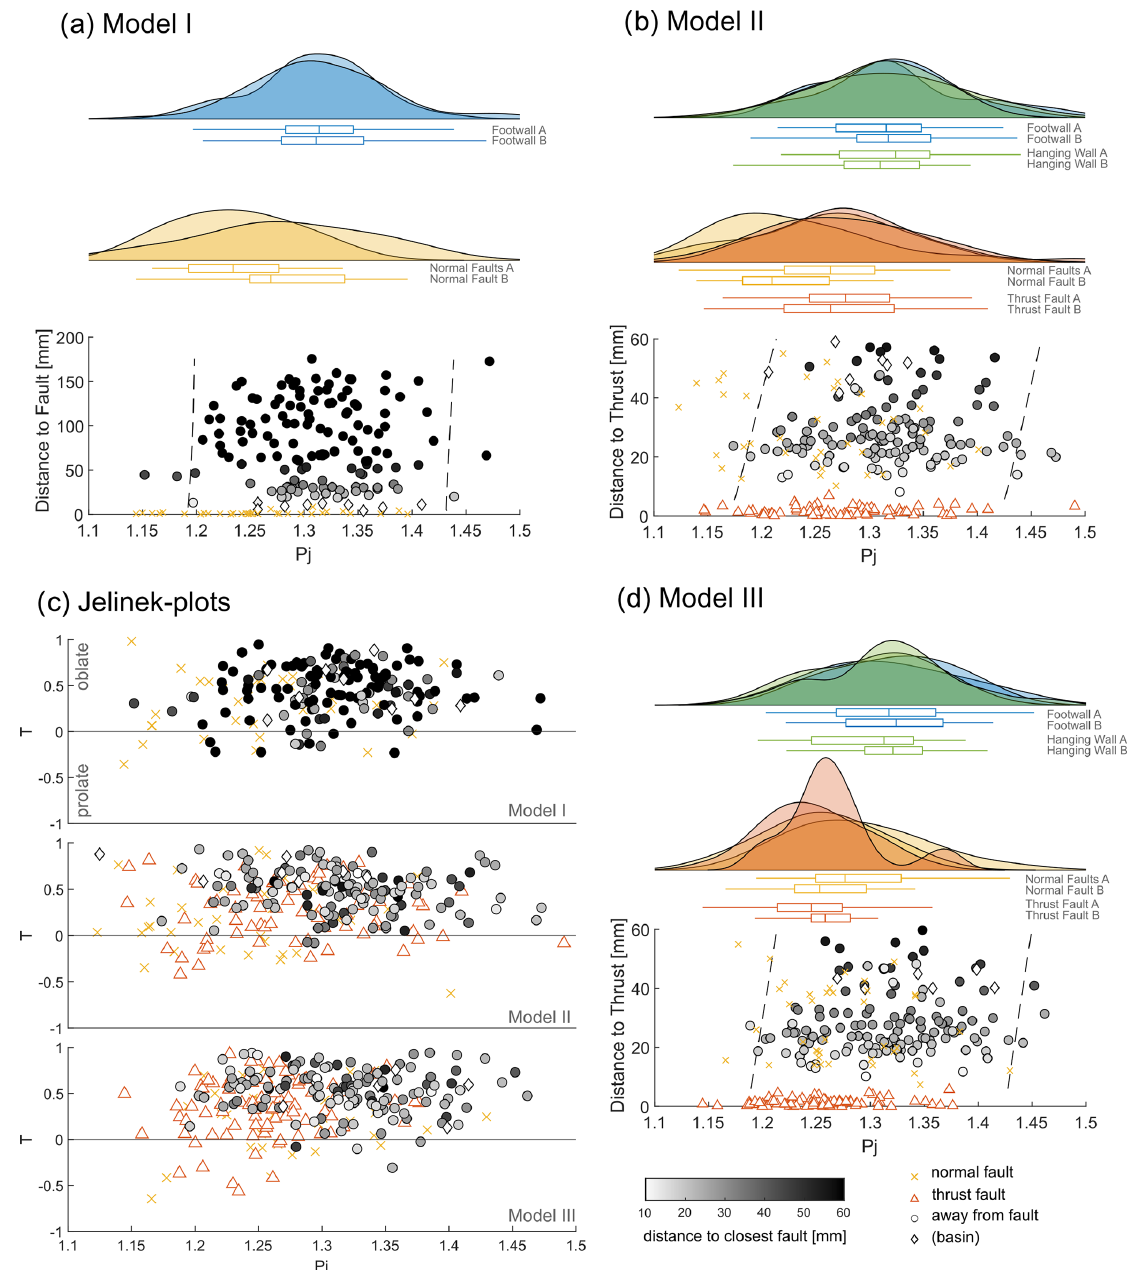
Figure 3. Distribution of the degree of anisotropy (Pj) is plotted as density distribution for each structure against the distance to the closest normal fault or thrust for (a) Model I, (b) Model II, and (d) Model III. Panel (c) shows Jelinek plots (degree of anisotropy Pj against the shape of anisotropy T ) for each model. Note that the greyscale colour map is defined by the distance towards the closest fault (normal fault or thrust). The dashed lines show the 95% confidence interval of the data away from the faults. The figure is using a modified MATLAB script of a raincloud plot by Allen et al.